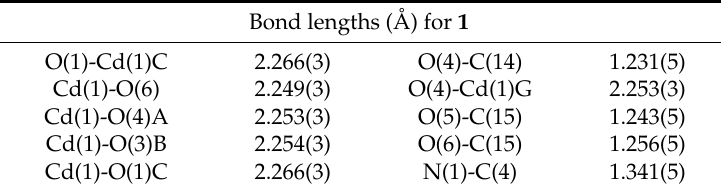
Table 2. Elected bond lengths (Å) and angles ( ◦ ) for compound 1